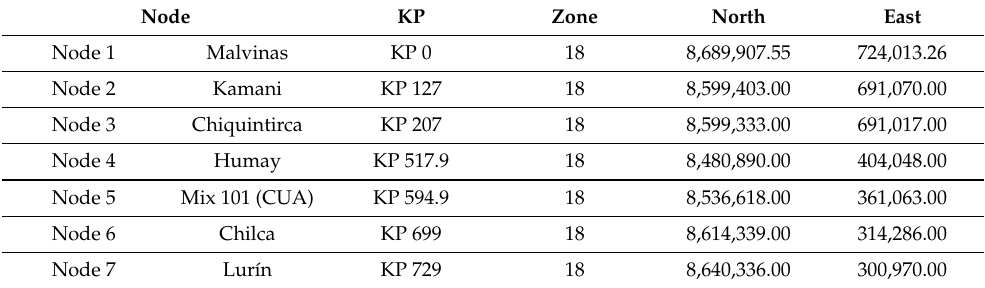
Figure 5. Equivalent model of the Peruvian NG network (adapted from Osinergmin [27]). Table 4. Reference points of the natural gas transportation company of Peru (from https:// observatorio.osinergmin.gob.pe/ accessed on 3 February 2022).